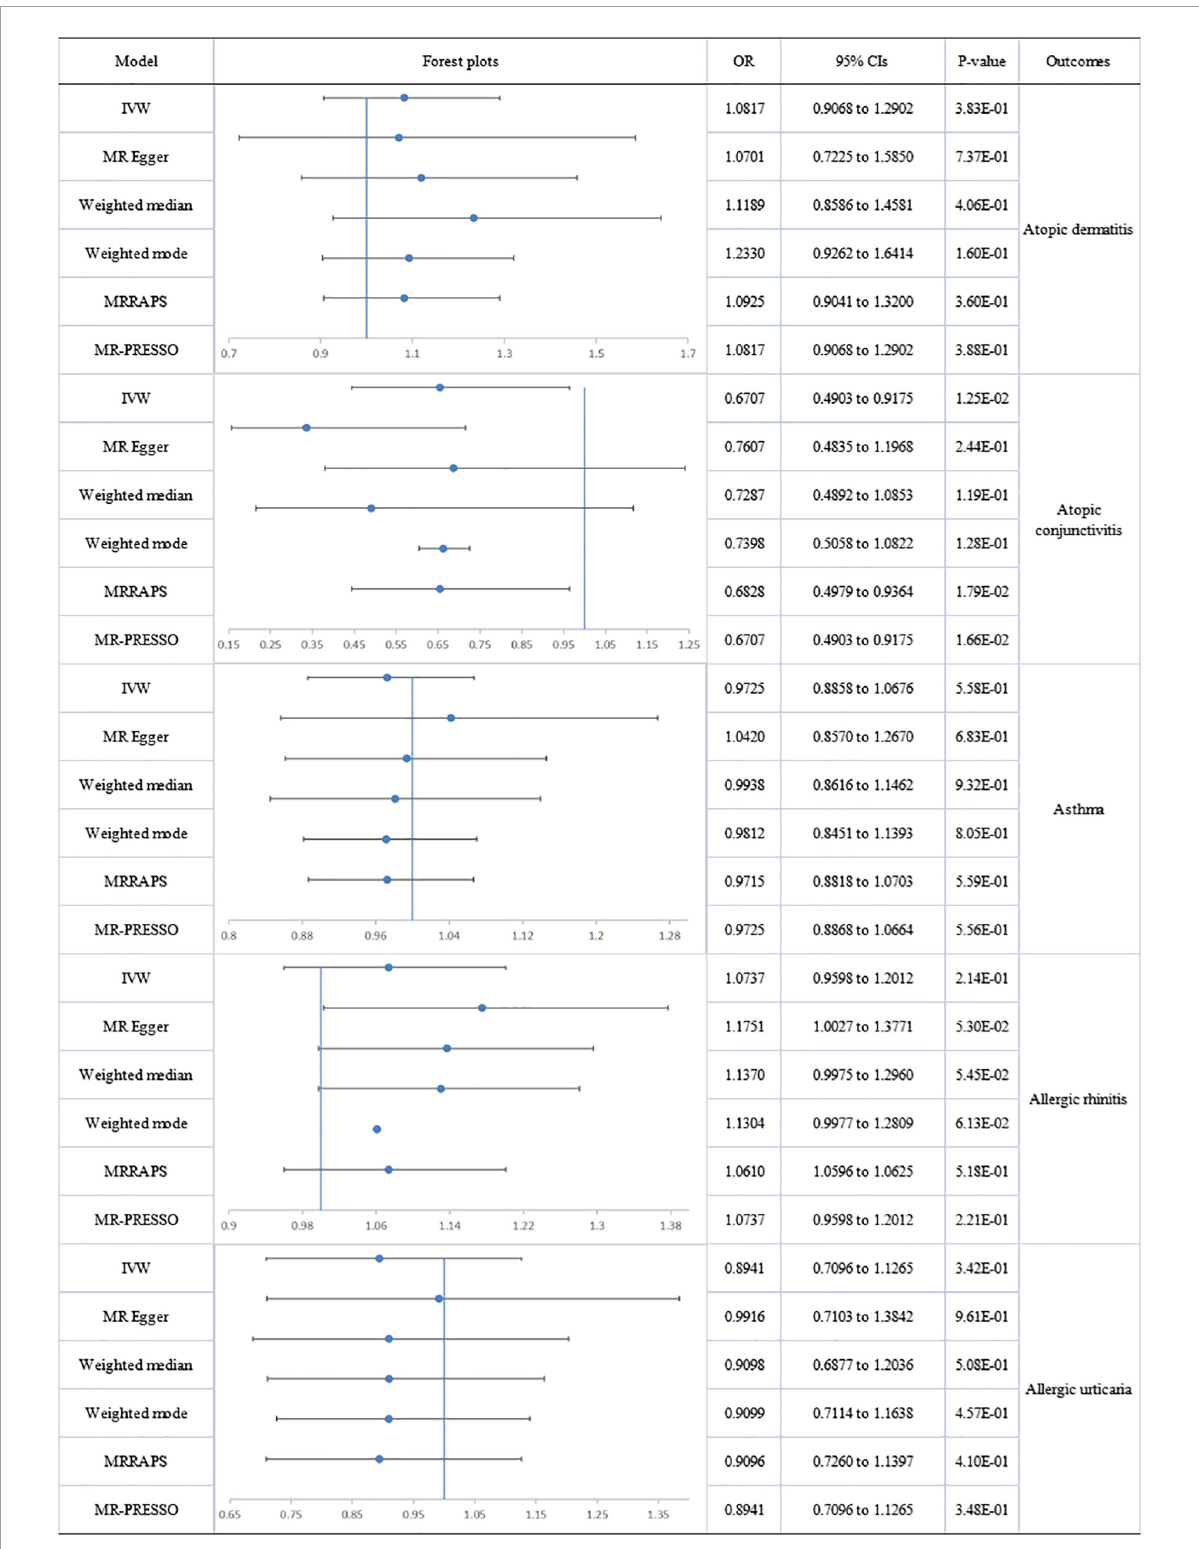
FIGURE4 The forest plot of univariable Mendelian randomization analyses exploring associations between docosahexaenoic acid and allergic diseases risk using different Mendelian randomization statistical models OR: odds ratio; CIs: confidence intervals.